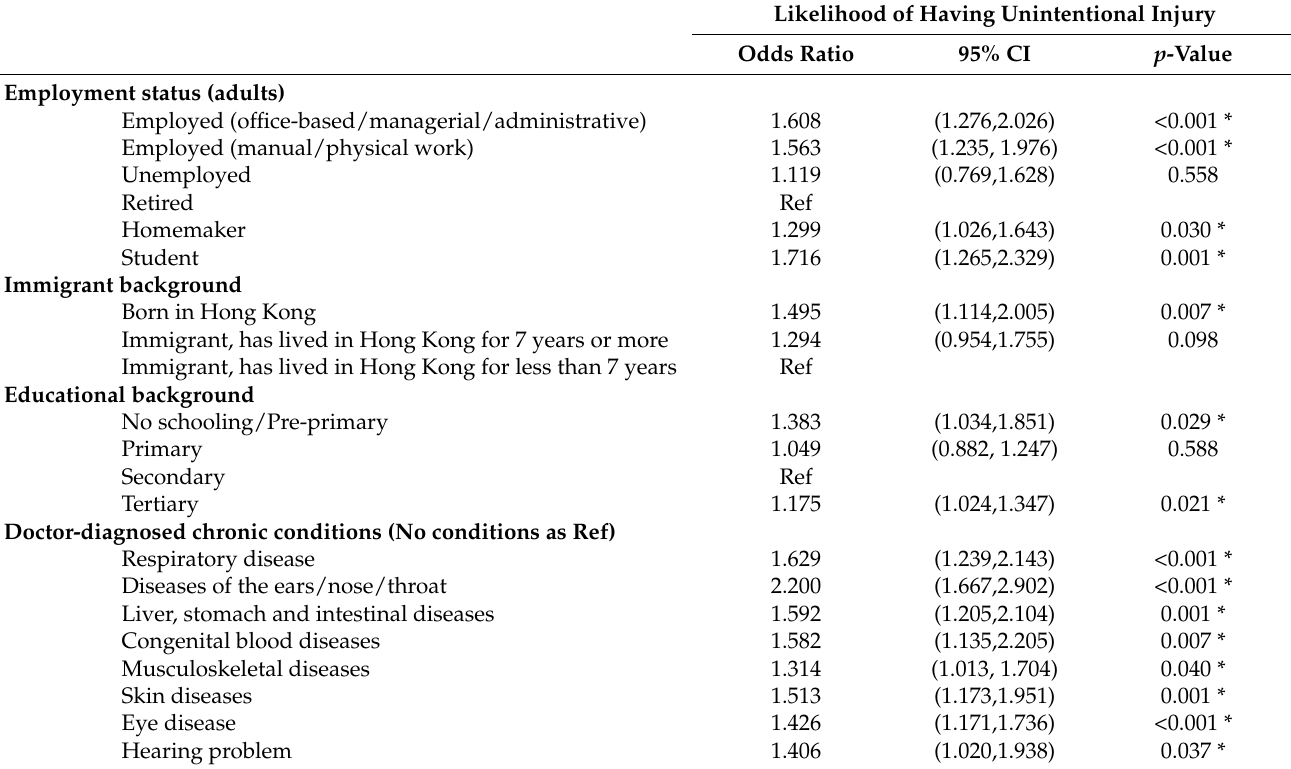
Table 4. Factors associated with unintentional injury by multivariable logistic regression